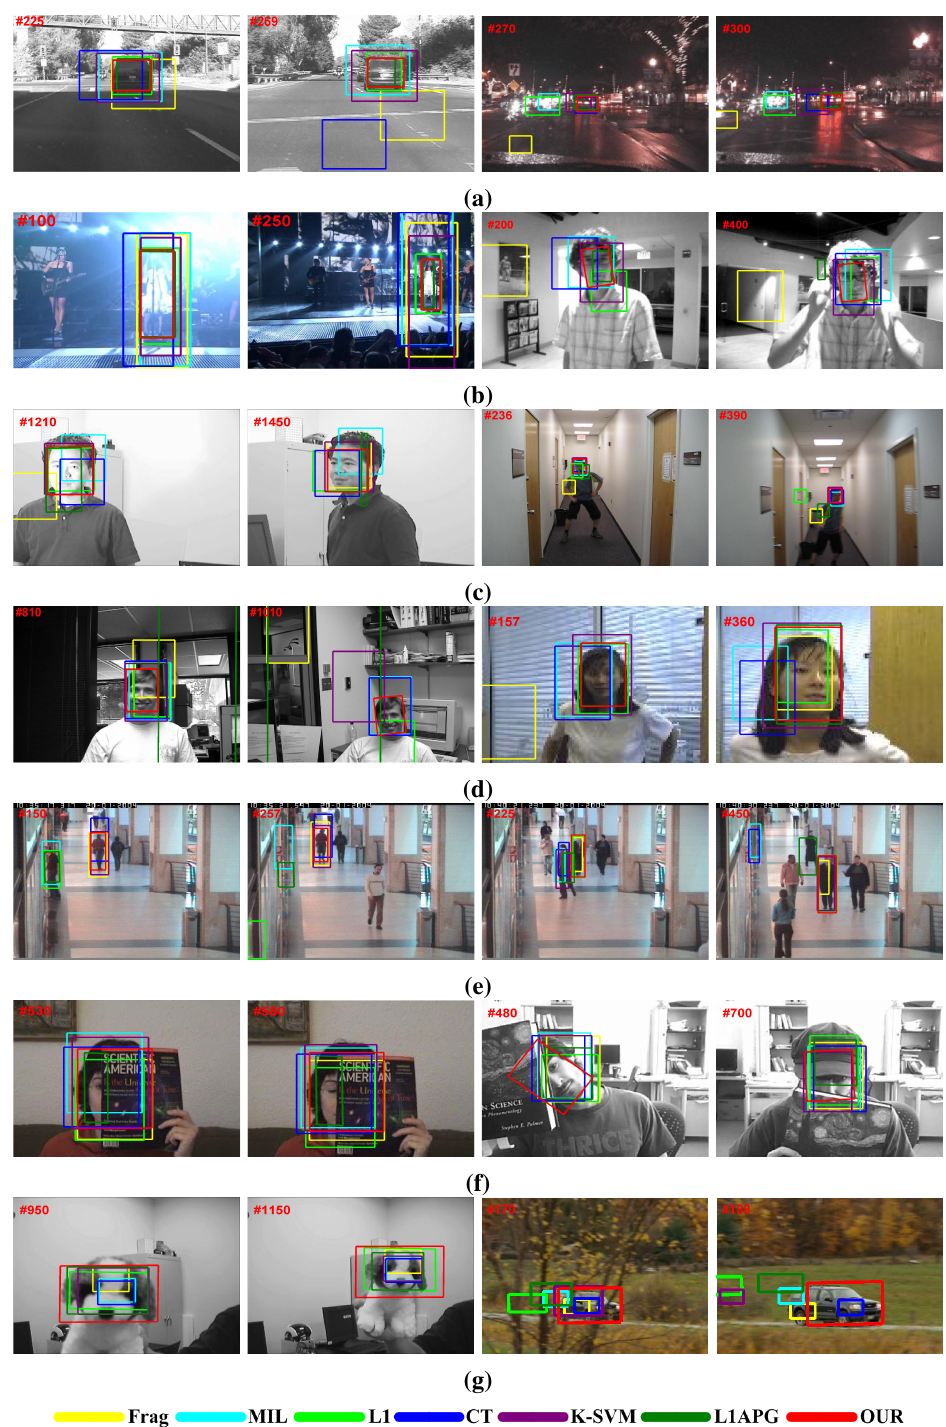
Figure 2. Representative tracking results on fourteen challenging sequences : ( a ) Car4 and Car11; ( b ) Singer1 and DavidIndoor; ( c ) Mhyang and boy; ( d ) Dudek and Girl; ( e ) Caviar1 and Caviar2; ( f ) Occlusion1 and Occlusion2; ( g ) Dog1 and